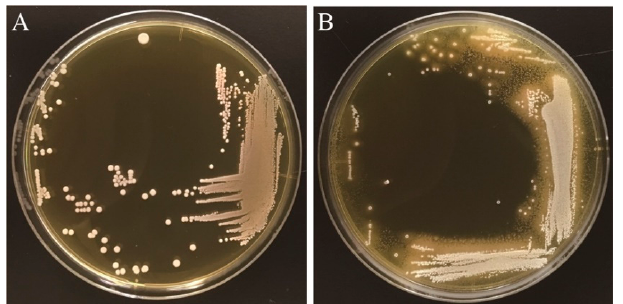
Figure 1. Bile salt hydrolase activity in Lactobacillus gasseri JCM1131 T . Full-grown culture of L. gasseri JCM1131 T was streaked on an MRS agar plate ( A ) or an MRS agar plate supplemented with 0.25% taurodeoxycholic acid ( B ). The plates were anaerobically incubated at 37 °C for 5 days. The visible halo surrounding colonies and the white precipitates with colonies are the well-known indicator of bacterial BSH activity